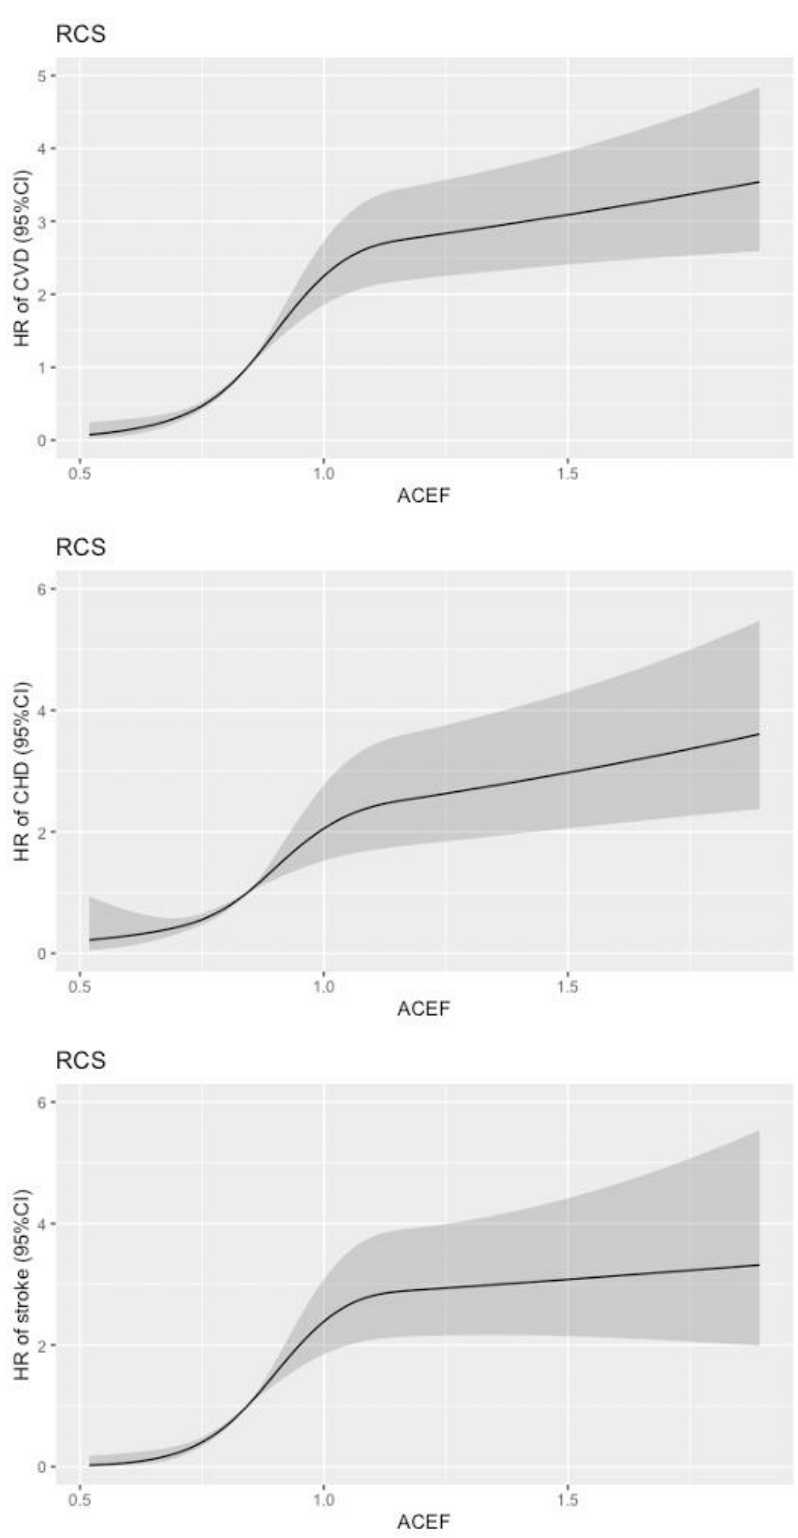
Figure 3. Restricted cubic spline plot of ACEF score and risk of CVD. The vertical coordinate is hazard ratio (HR), and the horizontal axis is ACEF score.